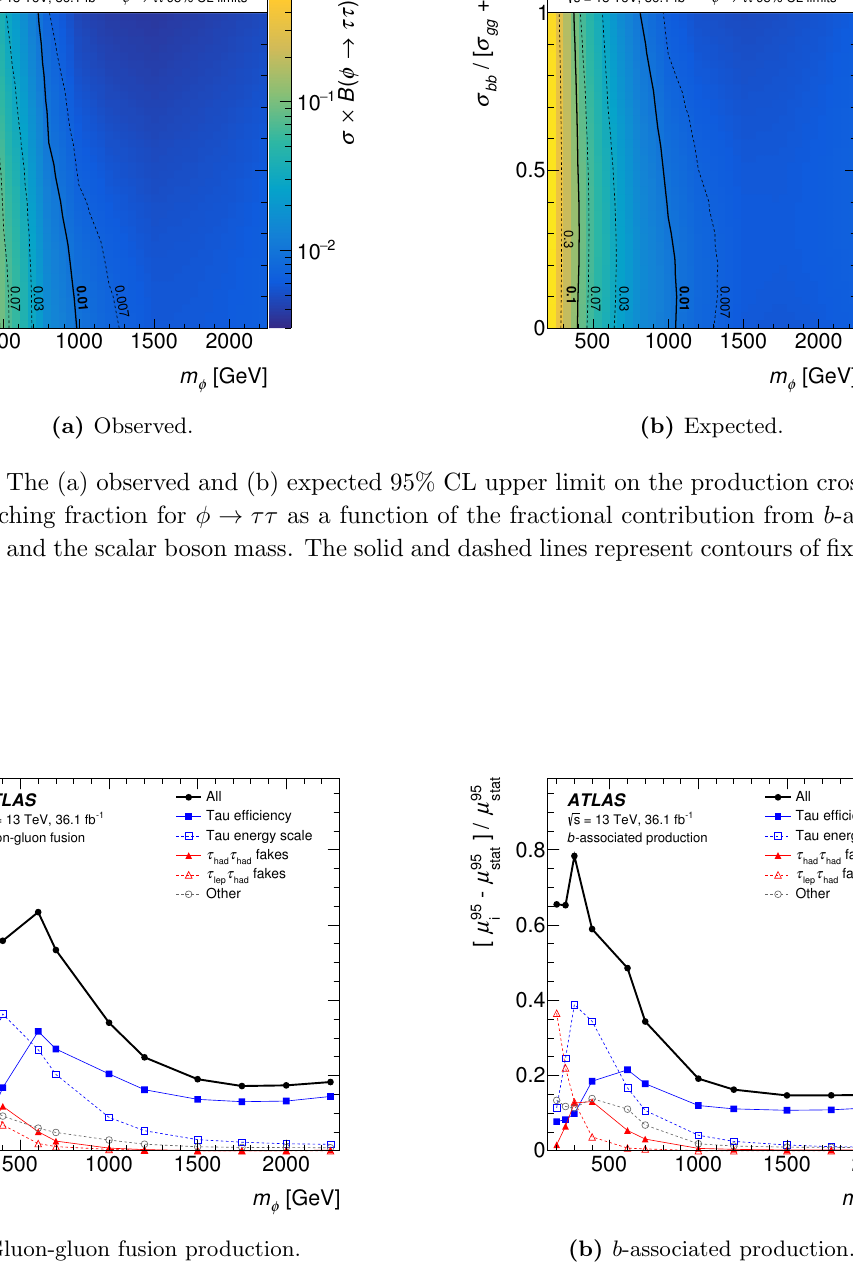
(cid:28)(cid:28) 95% CL cross section !